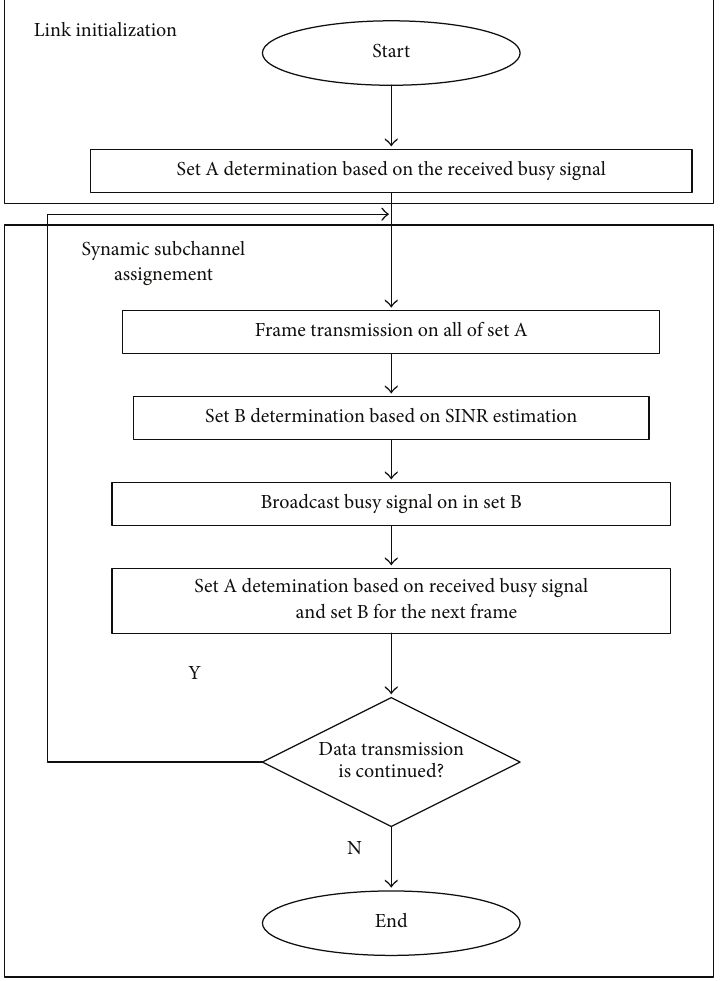
Figure 3: Flowchart of the proposed DSA